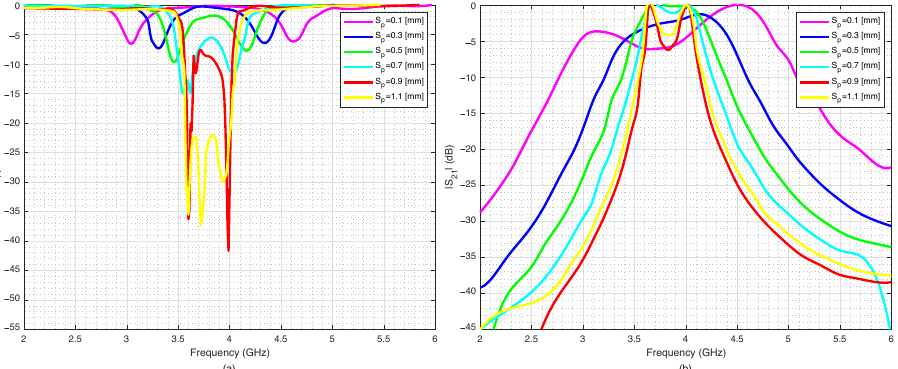
Figure 3. Pseudohairpin filter’s scattering parameters versus S p feeding line distance from resonator: ( a ) S 11 , ( b ) S 21